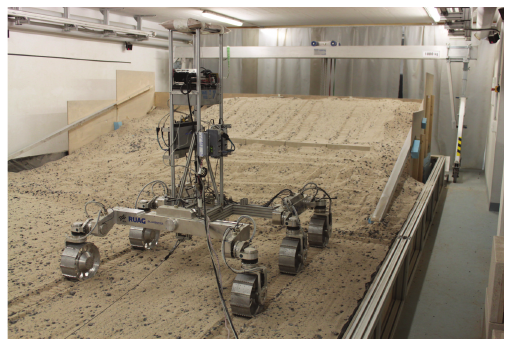
Figure 17: ExoMars Rover in the testbed.